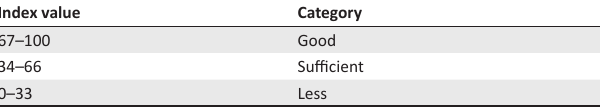
TABLE 1: Category level of